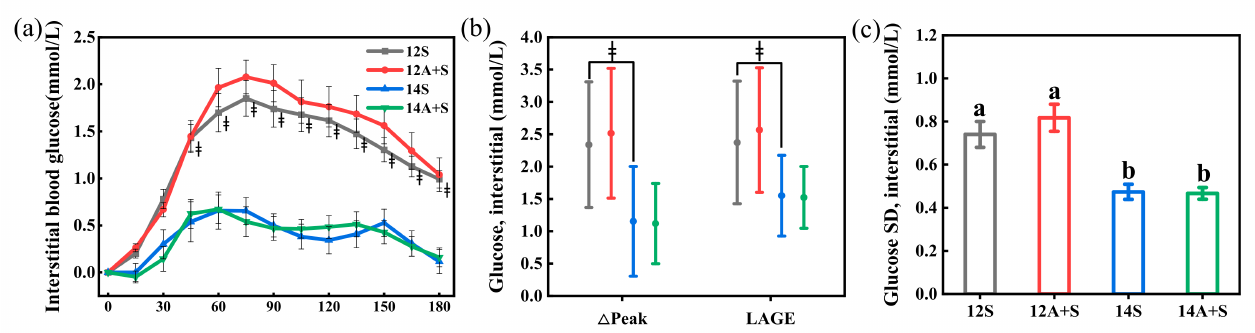
Figure 5. The postprandial interstitial glycemic response ( a ), the ∆ Peak and LAGE ( b ), and the SD ( c ) at a subsequent high-fat dinner. 12S, standardized lunch at 12:00; 12A+S, apple preload 30 min prior to 12S; 14S, standardized lunch at 14:00; 14A+S, apple preload 30 min prior to 14S. 0 min = the commencement of the dinner. Data are mean ± SD in figure ( b ), mean ± SE in other figures. ‡ 14S different from 12S ( p < 0.05). Significant differences ( p < 0.05) are represented by different letters on the bars in figure ( c ).